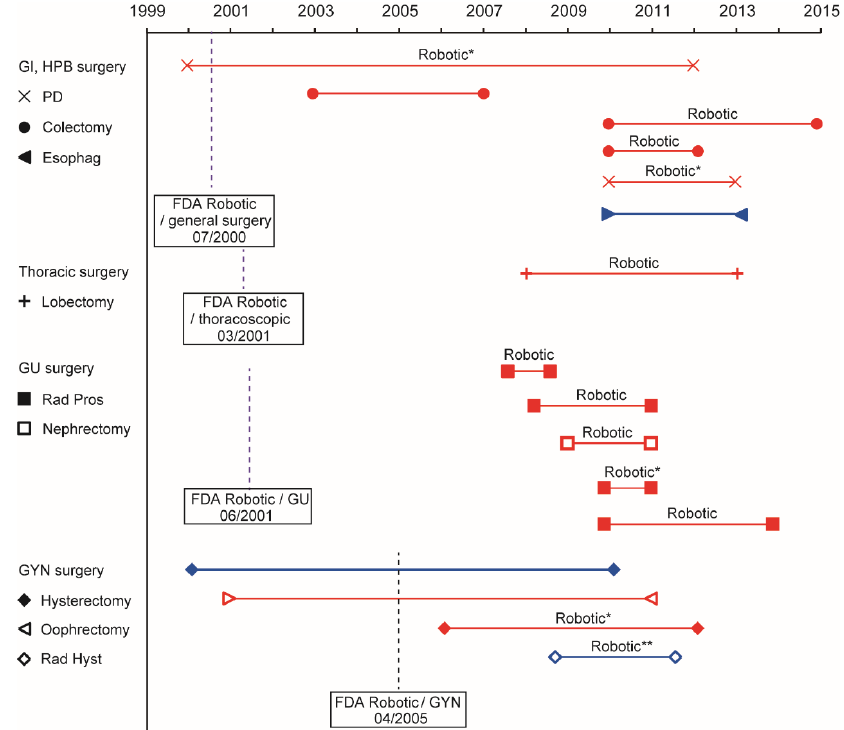
Figure 3. Association between the study period and volume–outcome. Studies from United States are included in this figure. * Mixed with conventional laparoscopic surgery. ** Cases with conventional laparoscopic surgery were excluded from this analysis. Red shapes and lines: the volume – outcome association for perioperative outcomes was observed. Blue shapes and lines: the volume – outcome association was not observed. Abbreviations: FDA Robotic, The Food and Drug Administration approval for robotic-assisted minimally invasive surgery; Robotic, robotic surgery; GI, gastrointestinal; HPB, hepato – pancreato – biliary, GU, genitourinary; GYN, gynecology; PD, pancreaticoduodenectomy; Esophag, esophagectomy; Rad Pros, radical prostatectomy; and Rad Hyst, radical hysterectomy.